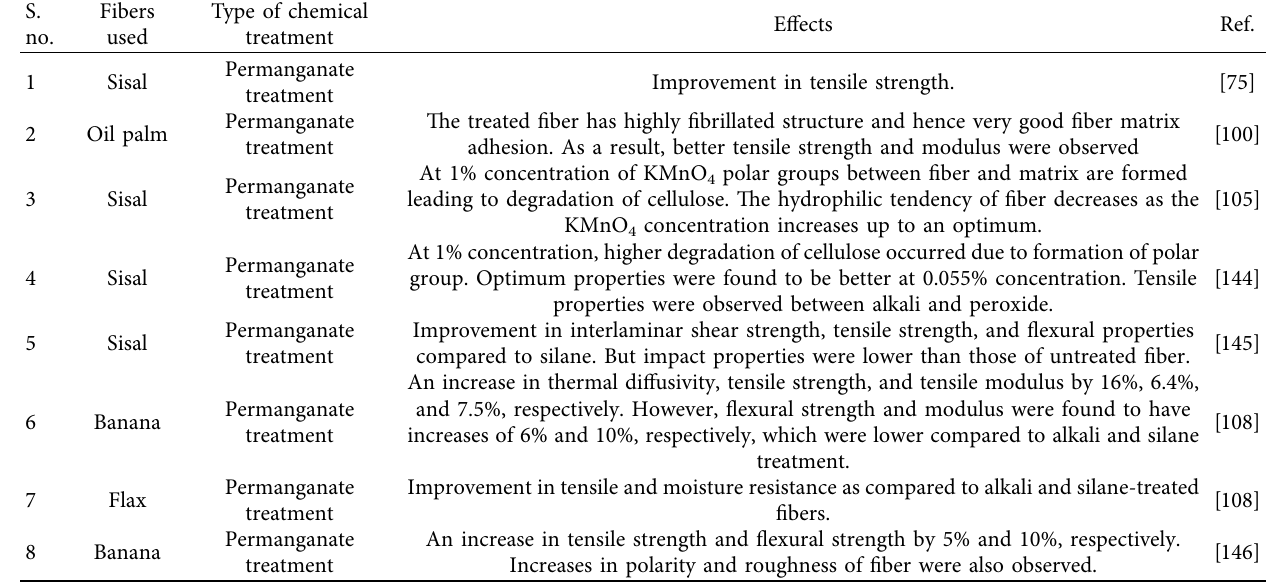
4 ) treatment on various biofibers.